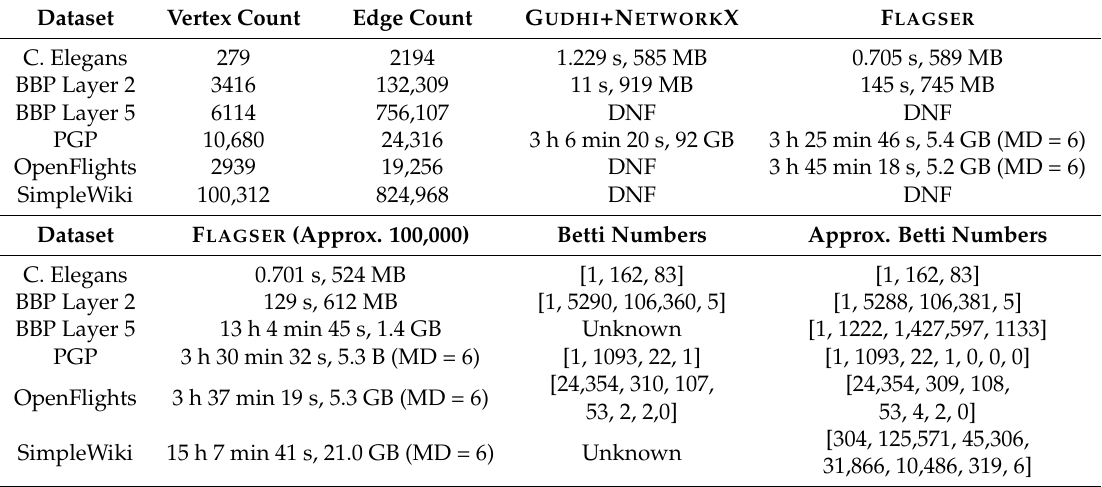
Table 7. A comparison of the run times of F LAGSER and G UDHI +N ETWORK X to compute the homology of the undirected flag complex of six undirected graphs. Where DNF denotes the computation did not finish in under 24 h, Approx. 100,000 denotes the use of the Approximate function of F LAGSER with value 100,000, and MD = 6 denotes the use of the max dimension option of F LAGSER to compute only up to dimension 6. In the cases where the max dimension option was used, the computation did not finish within 24 h without it. All computations were done on an HPC cluster using a single CPU. The BBP layers are taken from the Blue Brain Project website [1] and the other circuits are taken from KONECT [11]. We consider the graphs as simple undirected graphs for these computations, as such the edge counts in the table above may differ from the original graphs as reciprocal edges and loops were removed.